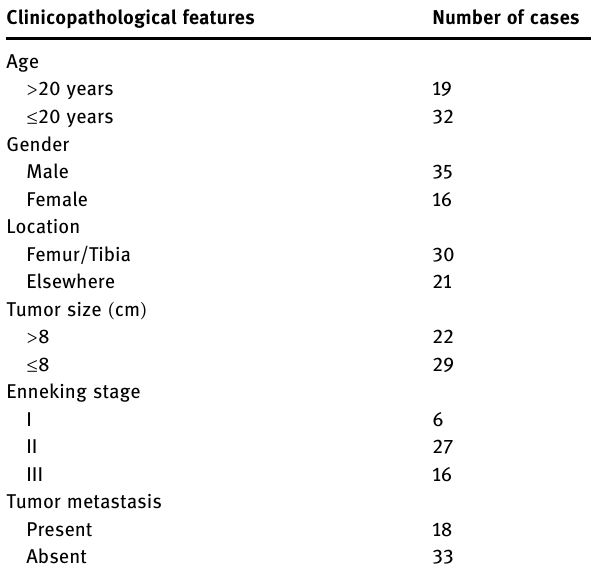
Table 1: Clinic - pathological information of the 51 OS patients Clinicopathological